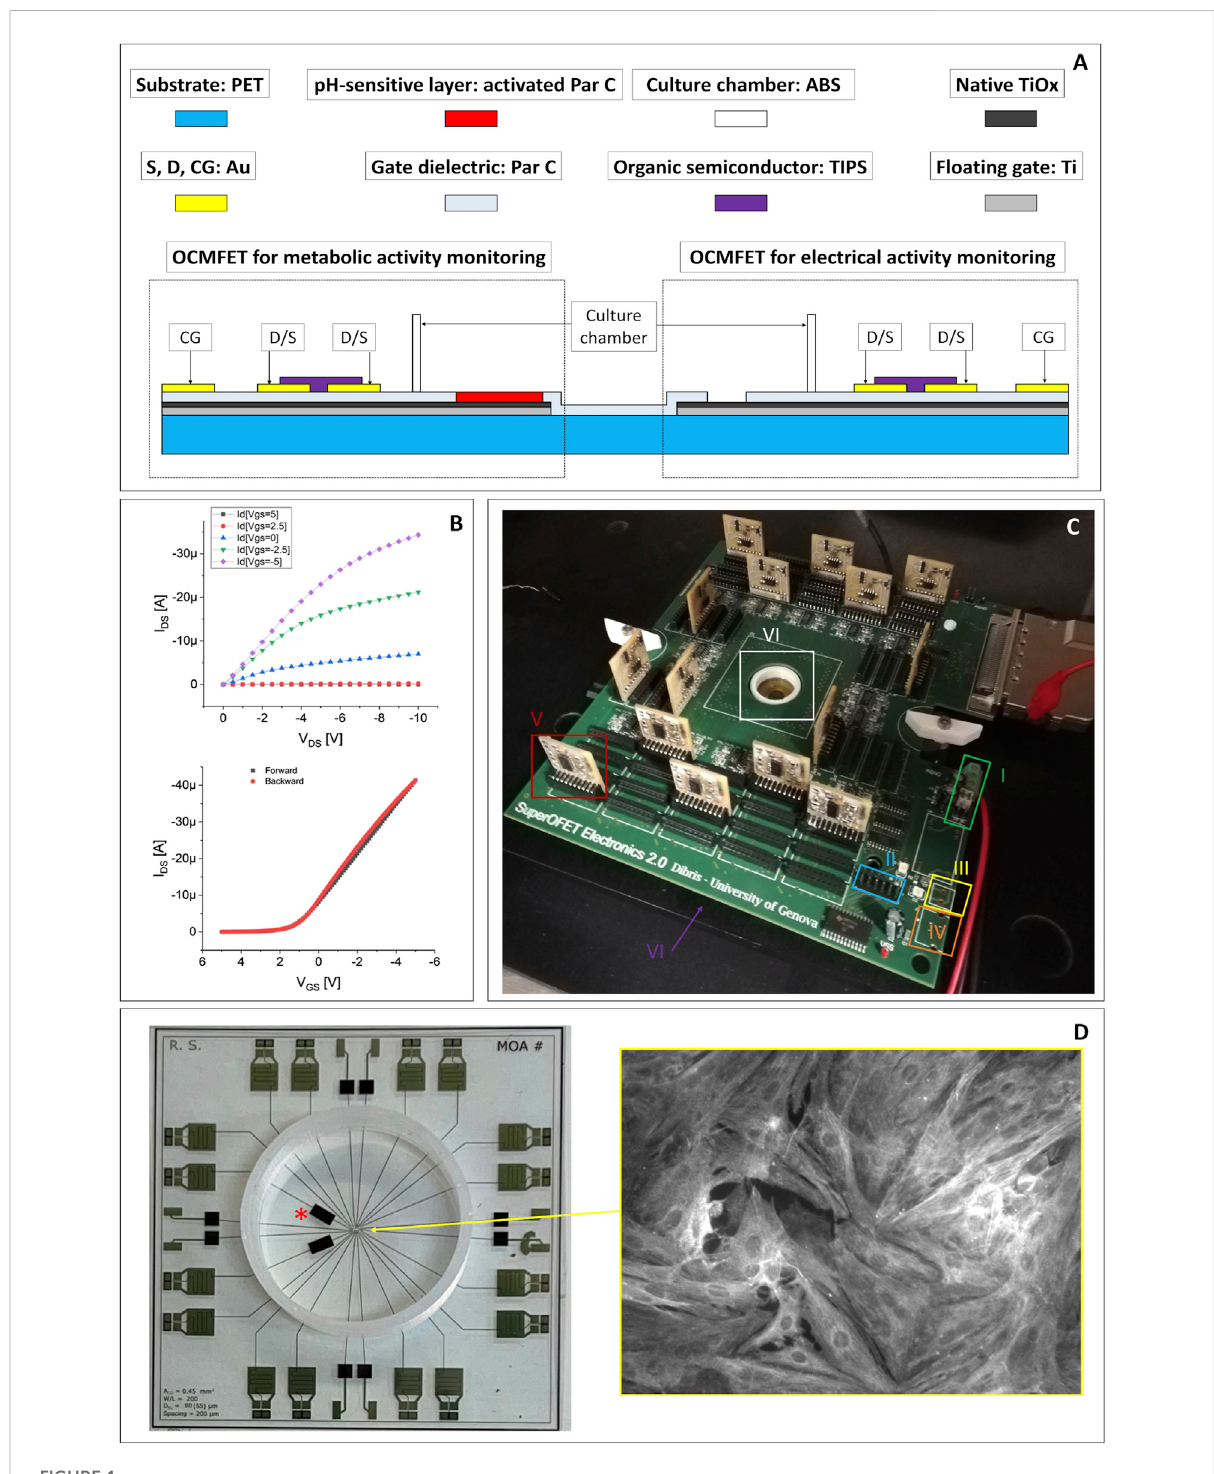
FIGURE 1 (A) Cross section and materials of a MOA for the simultaneous in vitro recording of the electrical and the metabolic activity of cell cultures (drawing not to scale). (B) Representative electrical output (top) and input (bottom) characteristics of one of the OCMFET employed in the experiments. (C) Thereadoutelectronics employed for theexperiments: 1)dualstabilizedexternal power supply; 2)connector for theprogramming of the digital potentiometers used to set each transistor ’ s working point; 3) USB external power supply; 4) single not stabilized external power supply; 5) modular PCBs (one for each channel), with the ampli fi cation of the output of each transistor (the I/V conversion is performed on the main board, right next to the recording site); 6) culturing chamber. (D) Top view of a completed MOA with the pH channels (*) and a cardiomyocytes culture fi xed and then immunostained for the sarcomeric α -actinin protein